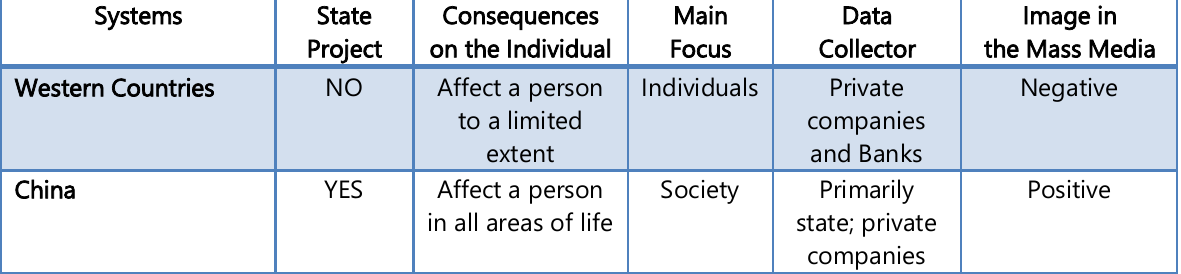
Table 1: The Main Differences Between SCS in China and Western Countries (Source: Authors‘ depiction) Systems State Consequences Main Data Image in Project on the Individual Focus Collector the Mass Media Western Countries NO Affect a person to a limited extent